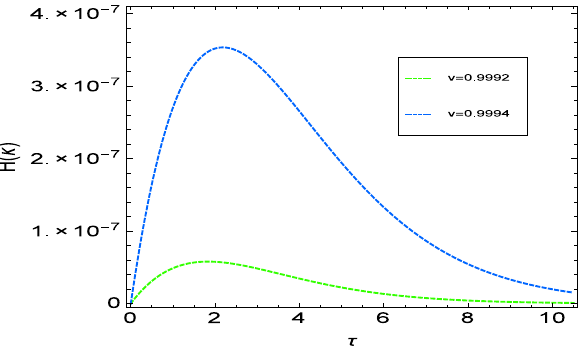
Fig. 2 QFIintheestimationofthedeformationparameterasafunction of the initial state parameter θ with fixed effective time τ . The effective deformation parameter is fixed as κ = 1000 and the velocity of detector isgivenby v = 0.Thedifferenteffectivetime τ = 1 , 6 , 8,respectively